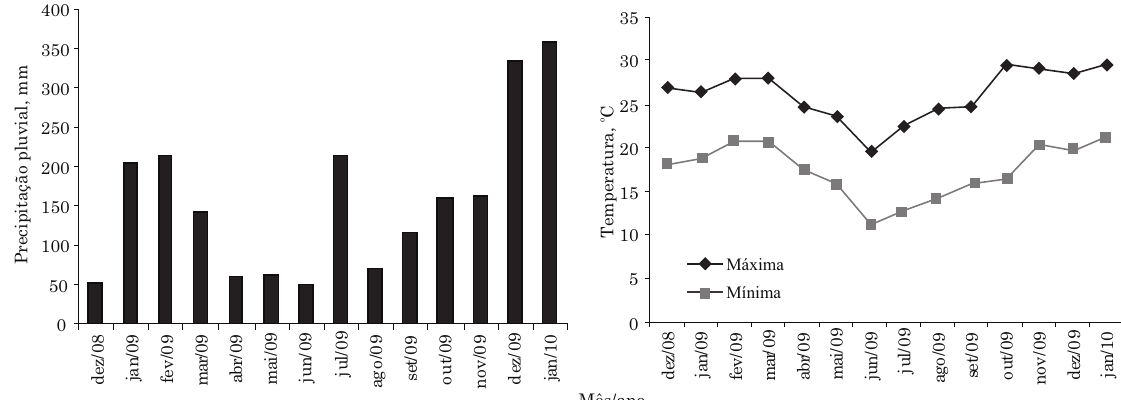
Figura 1. Dados de precipitação pluvial e temperaturas máximas e mínimas em Itapetininga, SP, no período de dezembro de 2008 a janeiro de